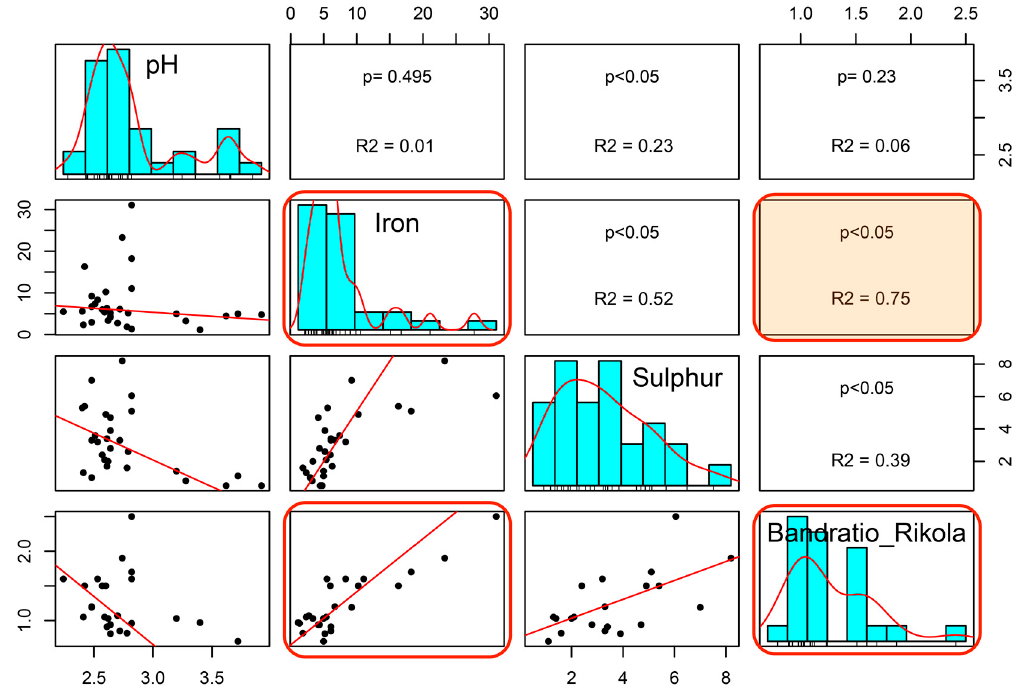
Figure 12. Extracted point values depicting the linear relationships between measured pH, iron and sulfur contents (XRF measurements in wt %) and the Rikola band ratio. The iron band ratio (720/880 nm) trend shows a linear correlation with ground measured Iron. Band ratio values >1.0 indicate iron minerals on the surface. Plotted p values and R 2 values indicate linear correlations among the data.